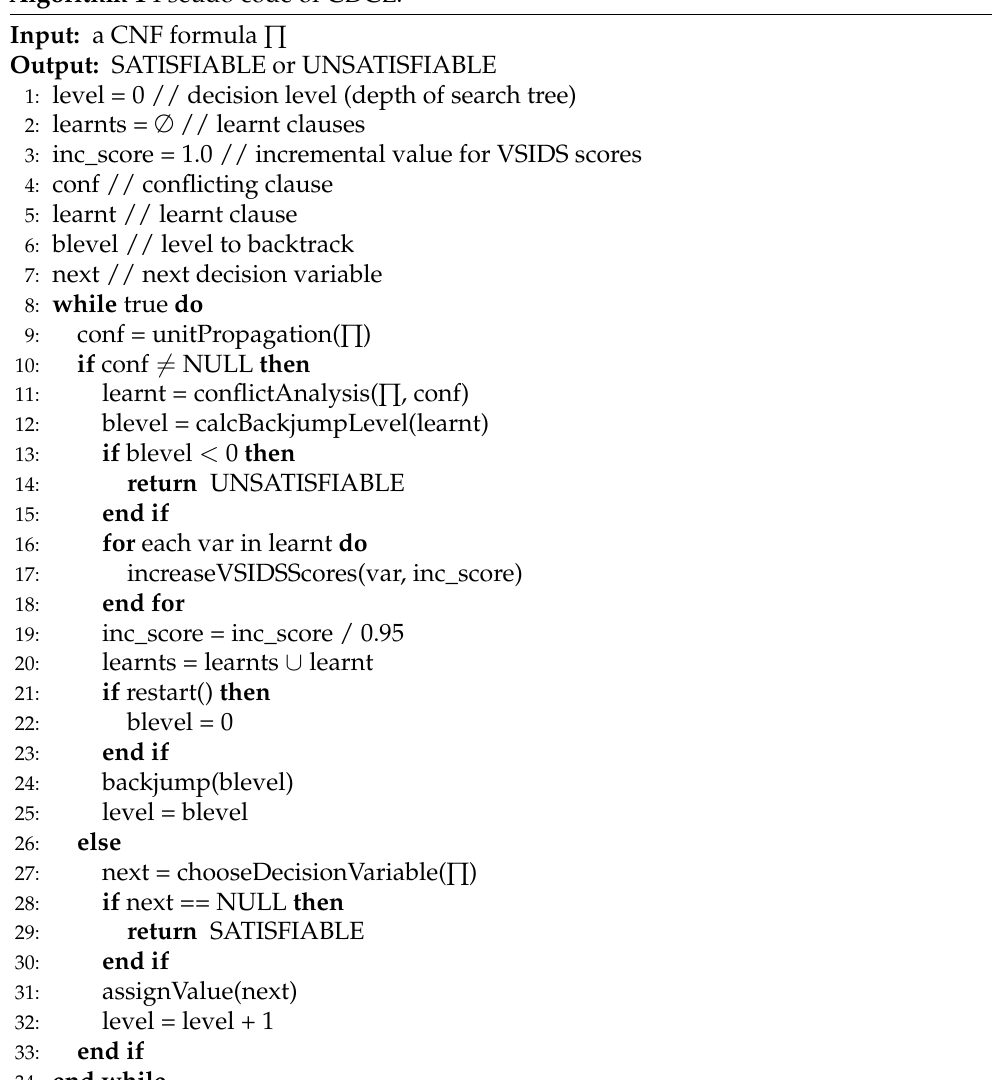
Algorithm 1 Pseudo code of